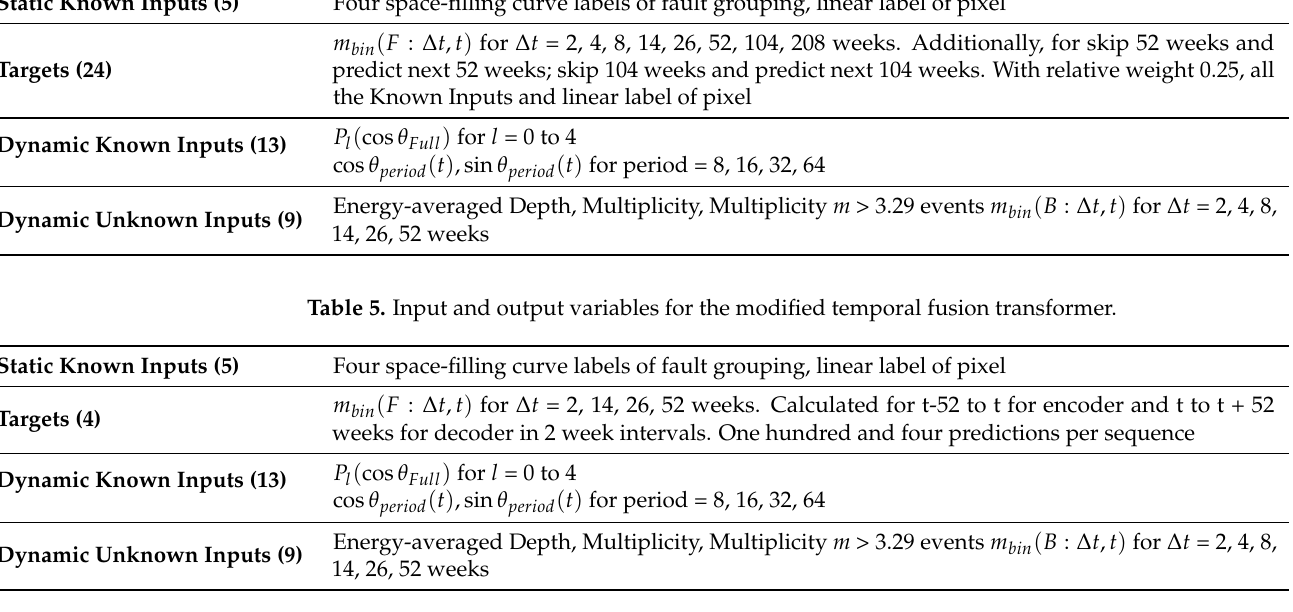
Table 4. Input and output variables for the LSTM and science transformer. Four space-filling curve labels of fault grouping, linear label of pixel